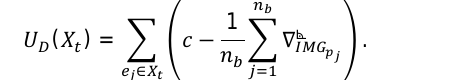
Figure 2: For each pixel (cid:1868) approximated by six vertices (yellow dots), we consider the sum of the components of the gradients ∇ normal vector (dark gray). ∇ pixels indicate the expected shadow within a bomb